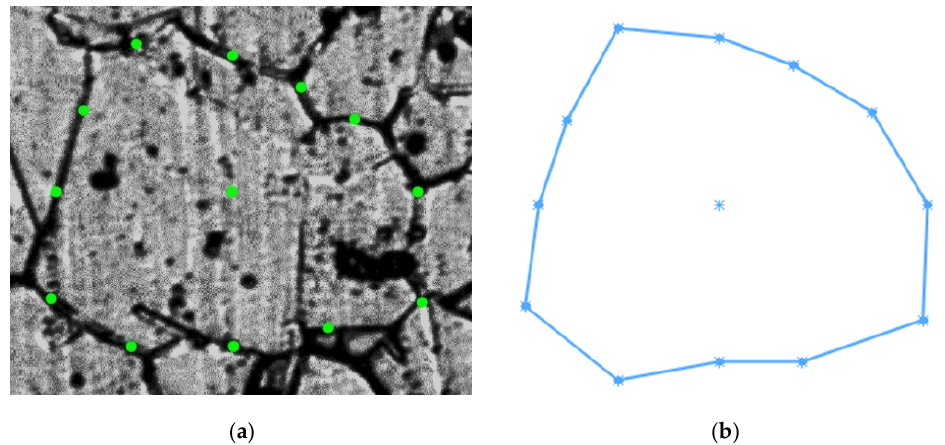
Figure 4. Origin and location of the points of the section with respect to the origin.